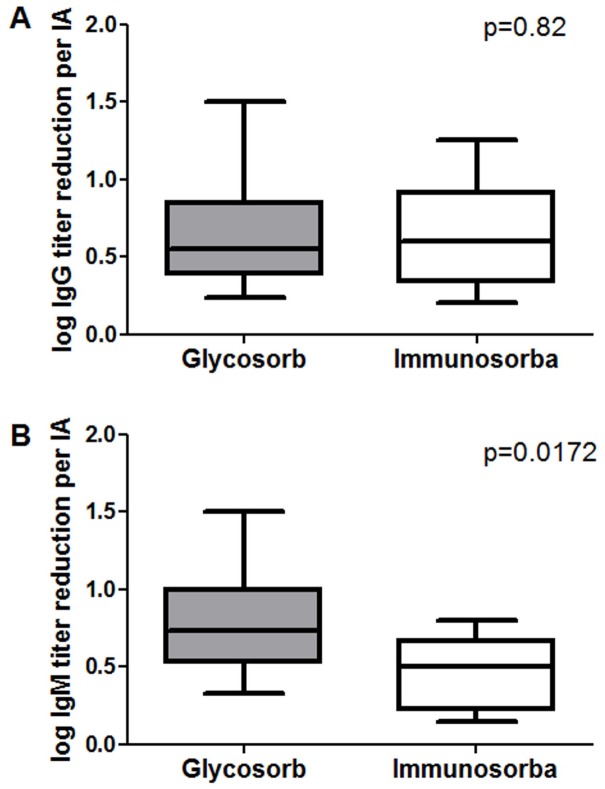
Reduction of Ig levels.(A) The reduction of IgG level per IA (shown in logarithmic steps) showed no noticeable differences in terms of efficacy between the IA groups (0.55 (0.24–1.5) vs. 0.6 (0.2–1.25), p = 0.82) (B) IgM levels were reduced more effectively by the antigen-specific Glycosorb IA (0.73 (0.33–1.5) vs. 0.5 (0.14–0.80), p = 0.0172).